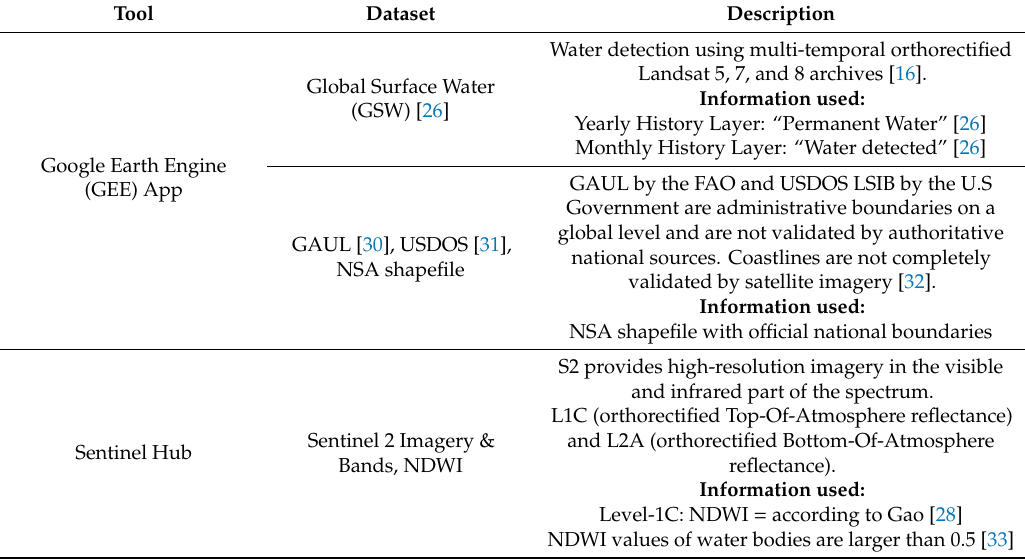
Table 1. Tools and Earth Observation (EO) data sources for the evaluation of Sustainable Development Goals (SDG) Indicator 6.6.1 (Water Surface Extent).